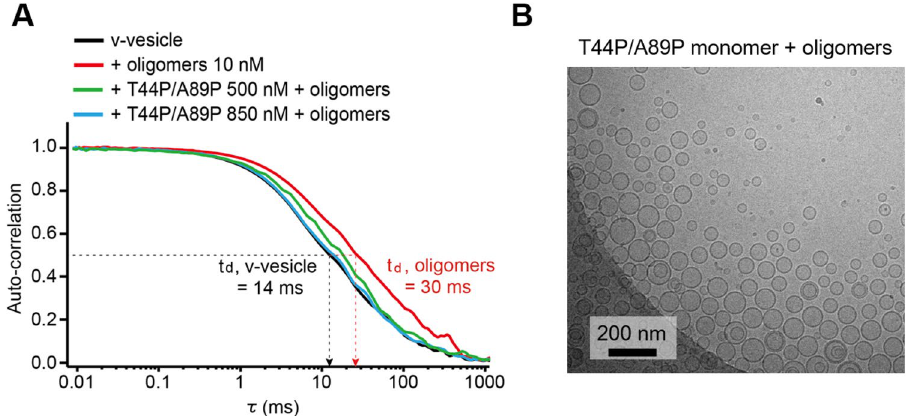
Figure 4. Lipid-binding-deficient α-Syn (T44P/A89P) reduces v-vesicle clustering induced by α-Syn oligomers. ( A ) Representative autocorrelation curves obtained by fluorescence correlation spectroscopy. The diffusion time (t d = τ at G = 0.5) denotes the average transit time of vesicles through the confocal volume (Supplementary Fig. S6). The average diffusion times of v-vesicles, v-vesicles with α-Syn oligomers, v-vesicles with α-Syn oligomers and 500 nM T44P/A89P, and v-vesicles with α-Syn oligomers and 850 nM T44P/A89P were 14.1 ± 0.2 ms, 31.6 ± 0.8 ms, 20.8 ± 0.2 ms, and 15.1 ± 0.3 ms, respectively (± SEM, N = 3). The graph shown